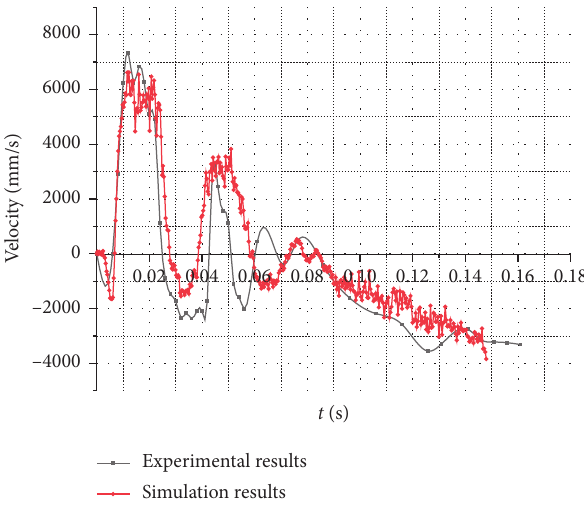
Figure 19: Comparison of the velocity-time history curves of the 18th